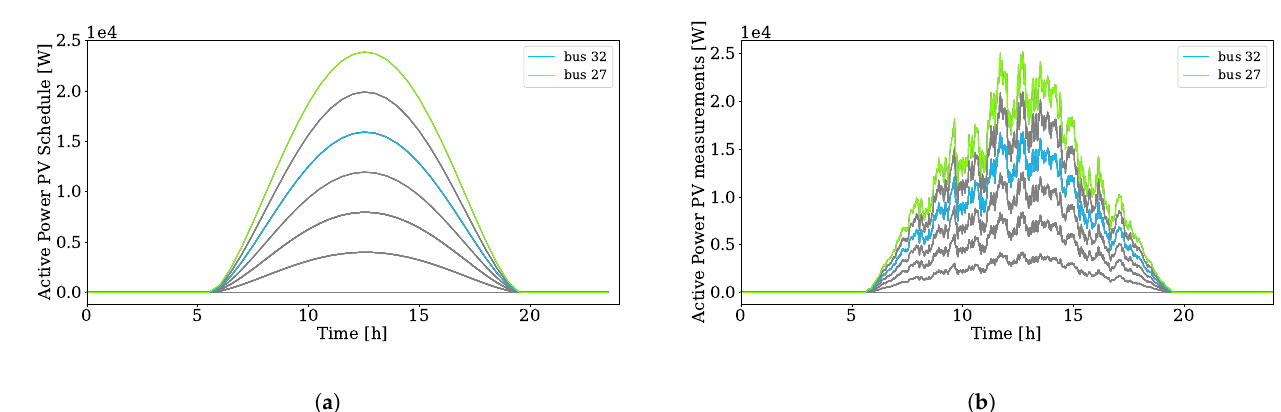
Figure 6. Generation profiles. ( a ) Forecasts of the generation profiles; ( b ) measurements of the generation profiles.